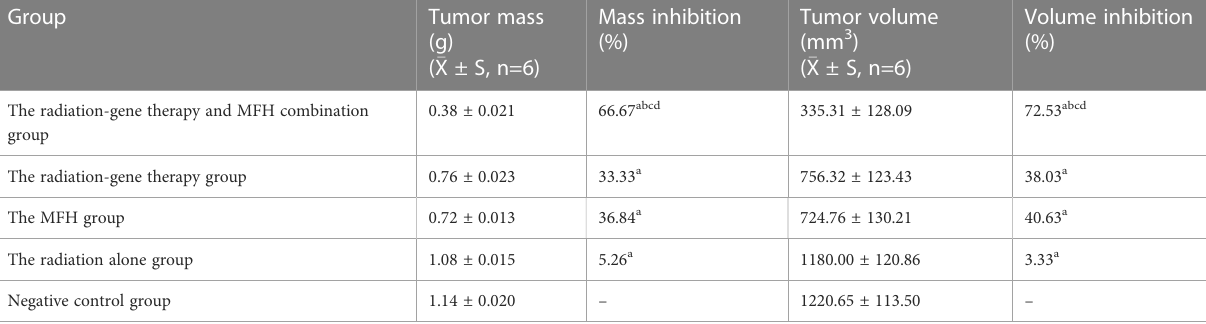
TABLE 2 Mass and volume inhibition of transplanted tumor of hepatoma in nude mice.